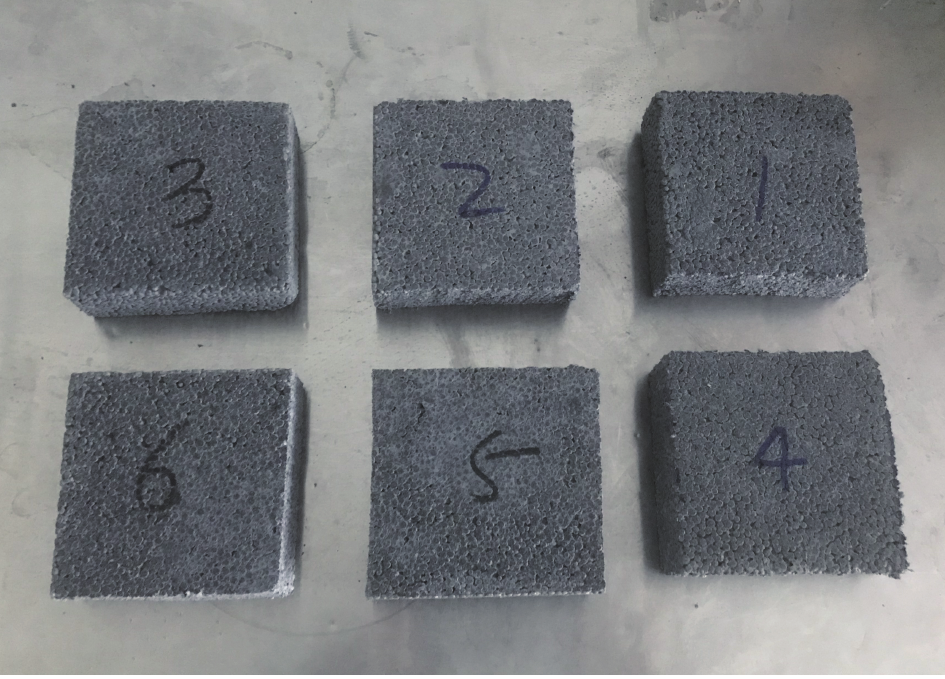
Figure 12. Samples of the prepared